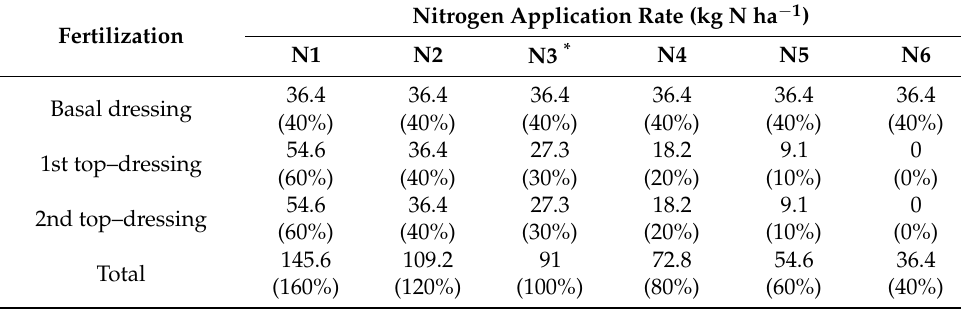
Table 2. Nitrogen application regimes in the